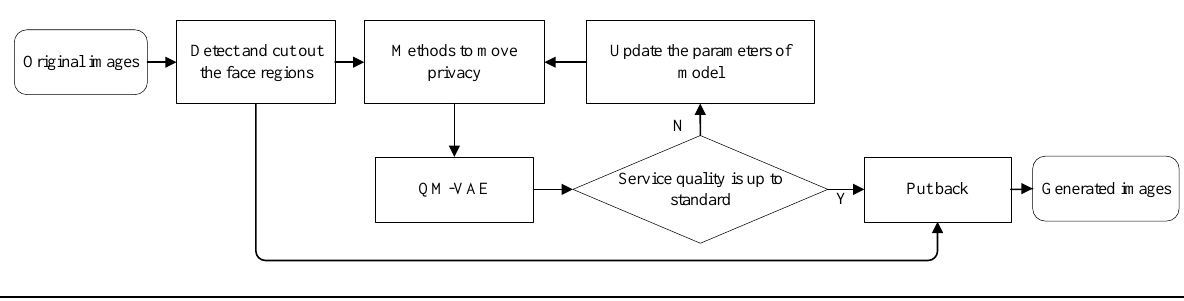
Figure 3. The flowchart of